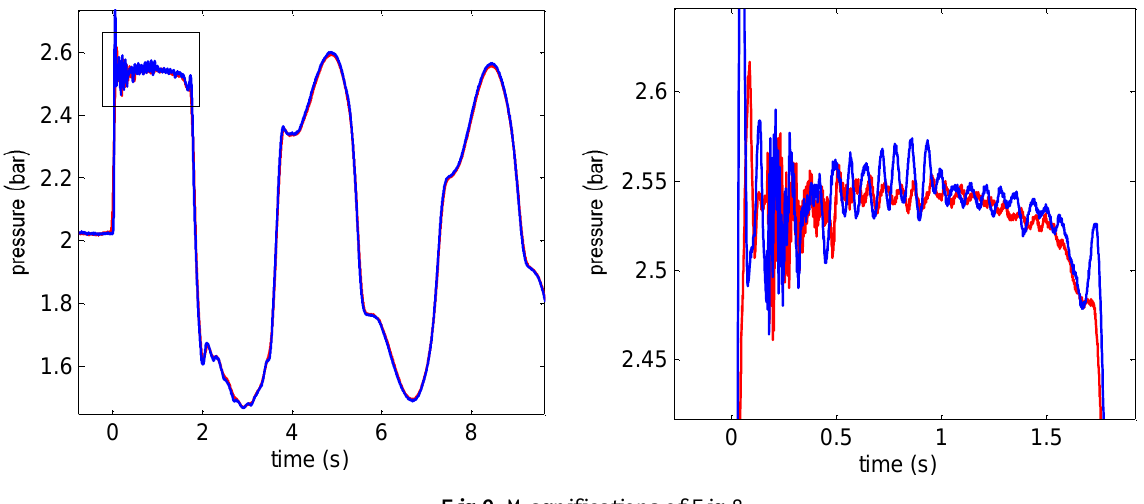
Fig 9. Magnifications of Fig